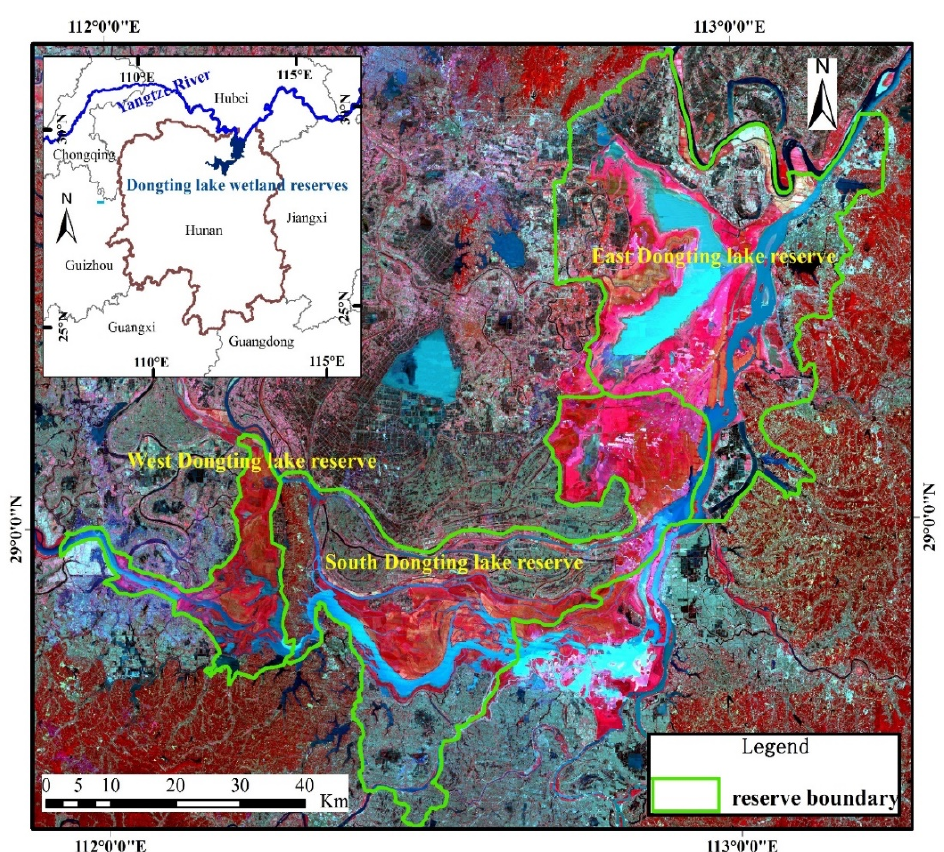
Figure 1. Location of study